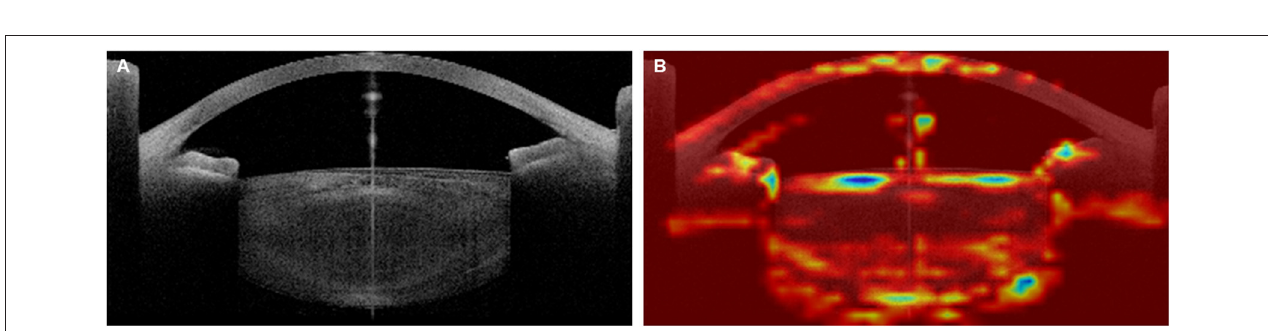
FIGURE 3 | Mean absolute error (MAE) of the model performance in the AI training process. As the size of the OCT image reduced, MAE increased (A) , and image augmentation using the image generator showed a lower MAE (B) . The ensemble model of Inception-v4 and ResNet showed the lowest MAE compared to the individual architecture (C) .